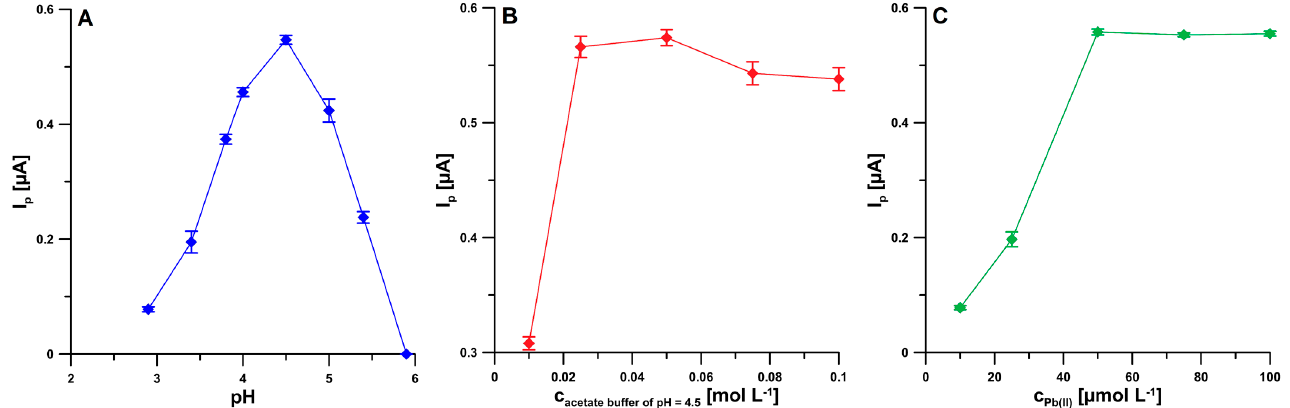
Figure 3. The dependence of pH ( A ), acetate buffer ( B ), and Pb(II) concentration ( C ) on the 2 nM BLM peak current. E acc. = − 1.0 V, t acc. = 120 s, f = 50 Hz, E SW = 50 mV, and Δ E = 10 mV. The received average values of the peak current are shown with a standard deviation for n = 3.